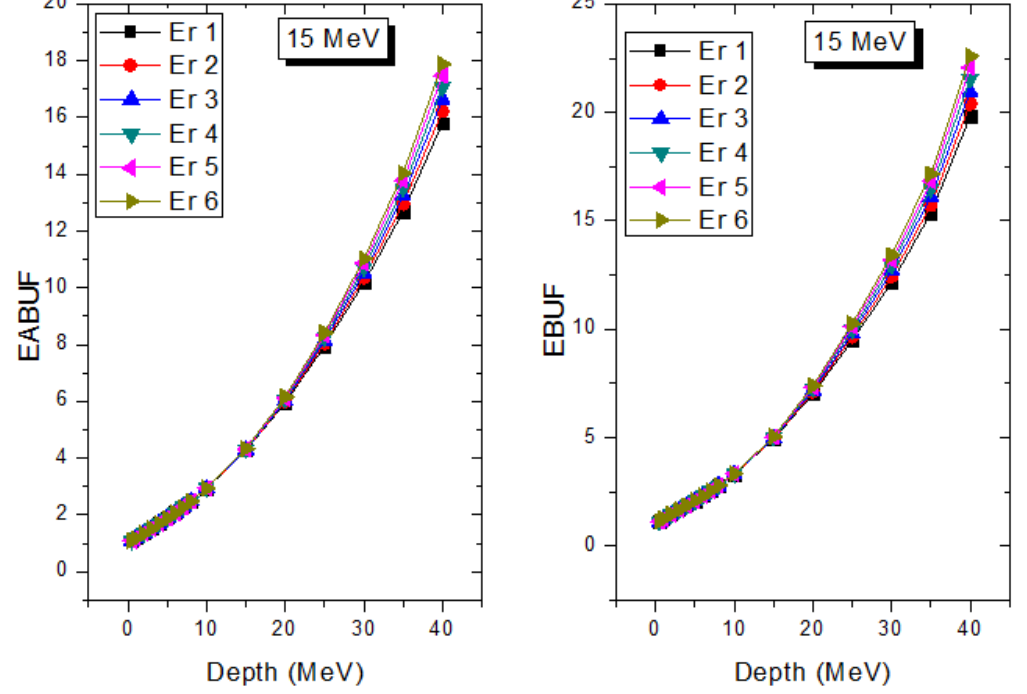
Figure 10. Effect of chemical composition on EABUF and EBUF at different depths for 15 MeV photon energy.